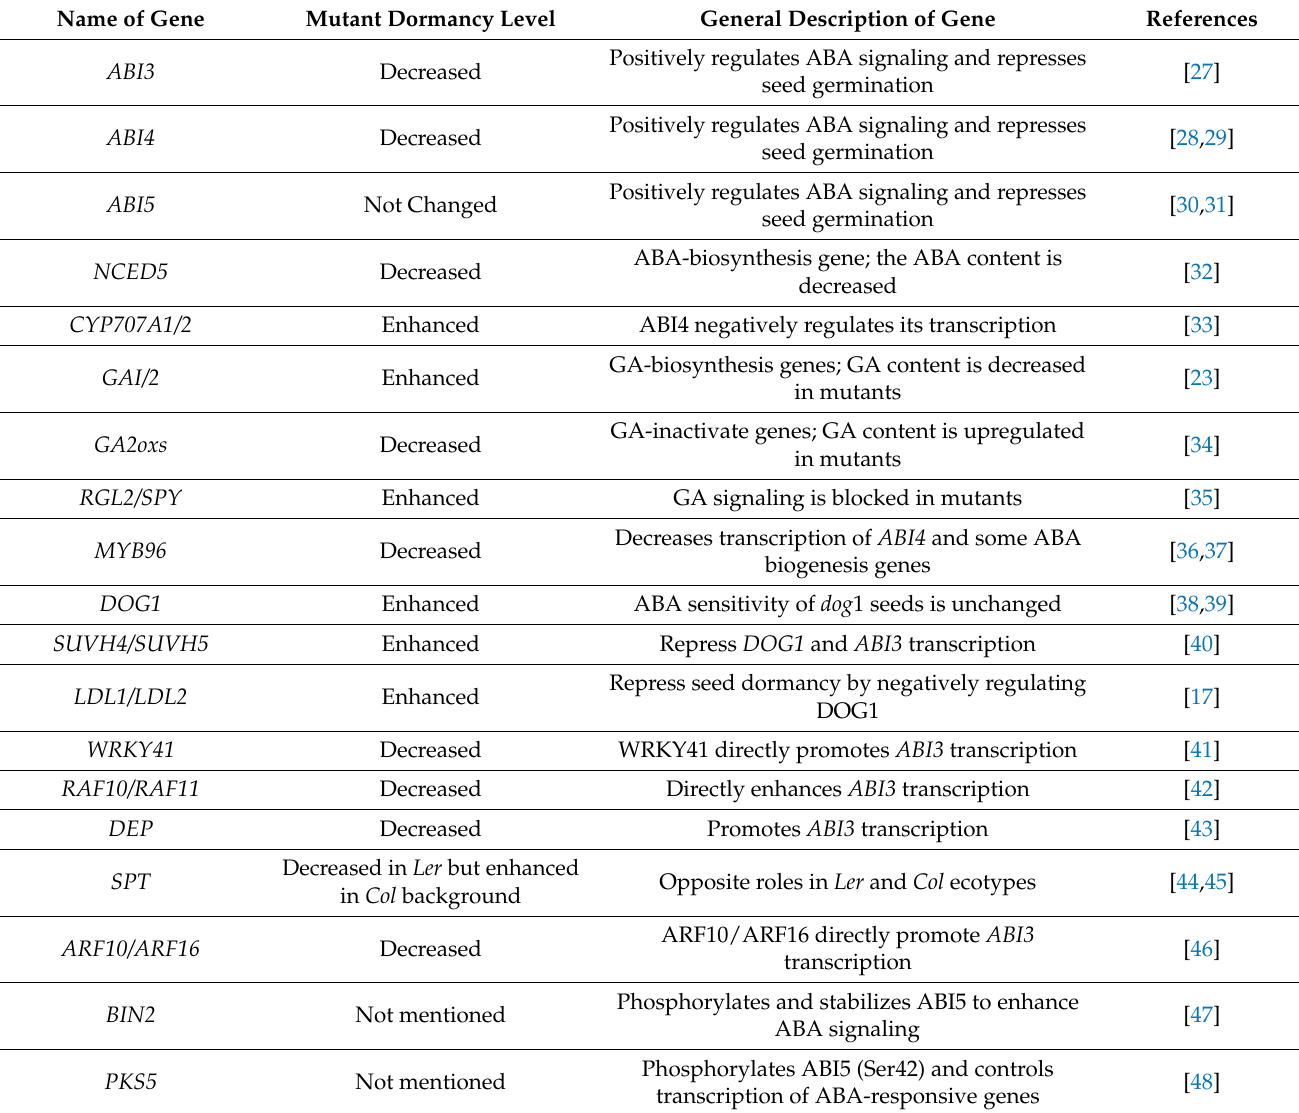
Table 1. Genes involved in seed dormancy and